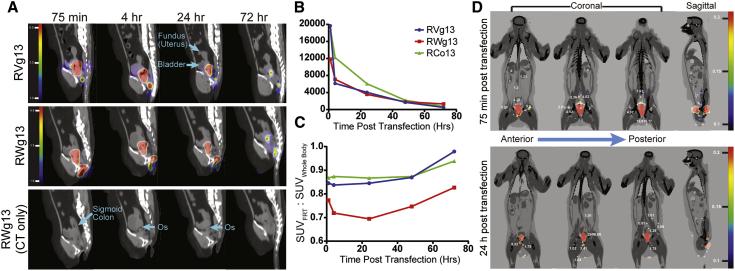
Longitudinal PET/CT Monitoring of 64Cu Radiolabeled aPGT121 mRNA after Aerosolized FRT Delivery(A–C) Two 125 μg doses of 64Cu radiolabeled aPGT121 mRNA were delivered via aerosol to first the cervix, then ~3–4 cm caudally in the vagina. A total of 200 μCi of 64Cu was administered. PET/CT imaging over 3 days was used to monitor mRNA biodistribution. (A) Representative PET/CT images of the abdomen and pelvis from 70 min to 72 h. Contrast enhancement was adjusted to reflect the high SUV signals within the FRT. (B) The total SUV in the FRT over time. (C) The ratio of the total SUV in the FRT to the total SUV contained within the entire body. (D) Whole-body PET/CT images of macaque RVg13 at 70 min and 24 h post-transfection. Numbers in white represent the total SUV within the nearby organ. Contrast enhancement was adjusted to allow visualization of draining lymph nodes.